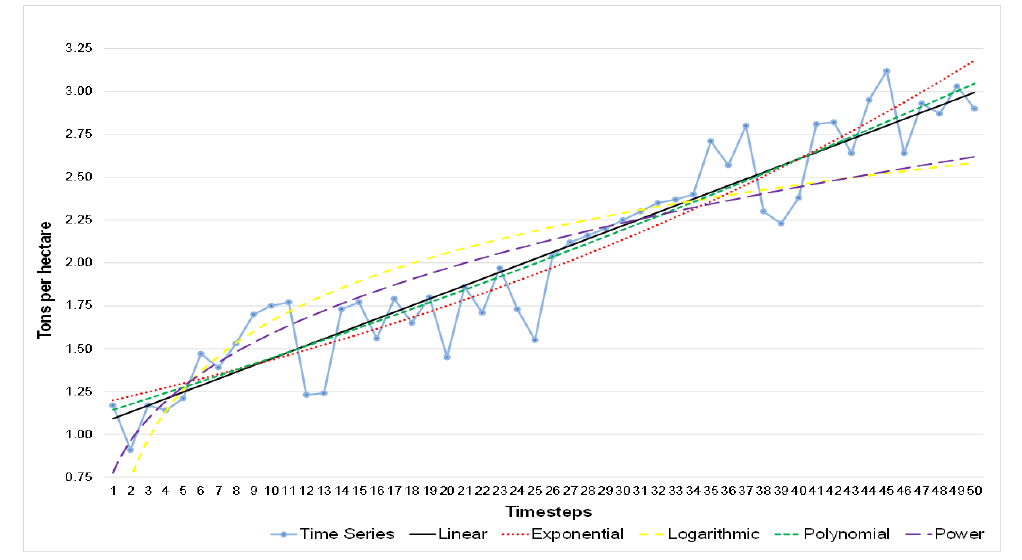
Figure 5. Original time series for